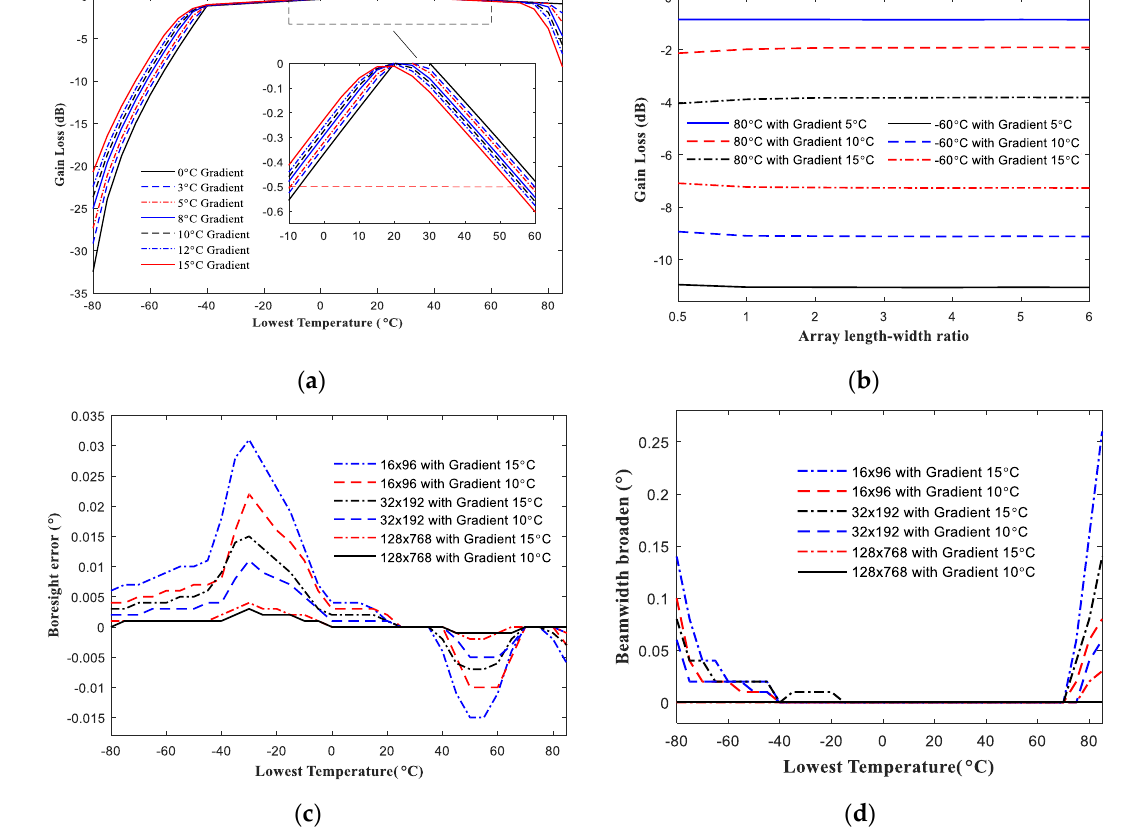
Figure 11. ( a ) Gain-loss versus the temperature gradient; ( b ) gain-loss versus the array size; ( c ) boresight error with temperature; ( d ) broadening of 3 dB beamwidth with temperature. Table 3. Gain-loss under the e ff ect of asymmetric temperature